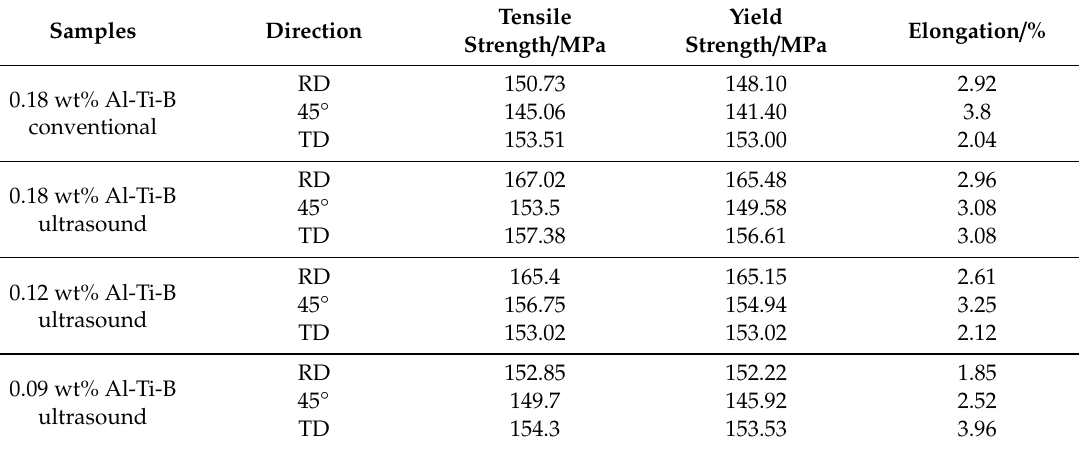
Table 3. Mechanical properties of subsequent cold rolling of the strips of the 1060 aluminum alloy cast rolling strip with di ff erent